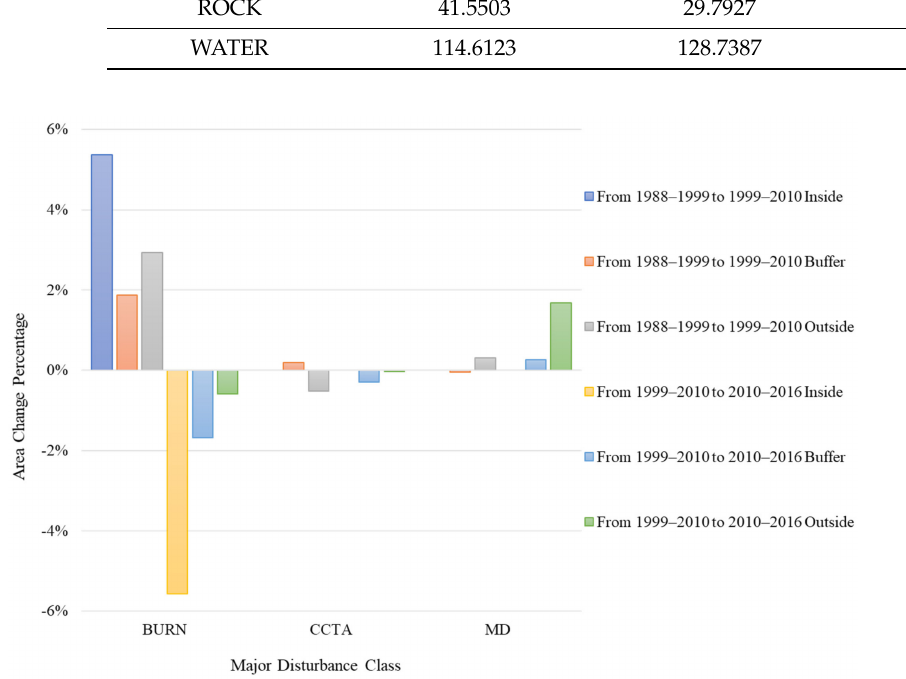
Figure 7. Area-change percentage of major disturbances inside, buffer zone, and outside the reserve, from the period of timber or agricultural, and MD = mixed